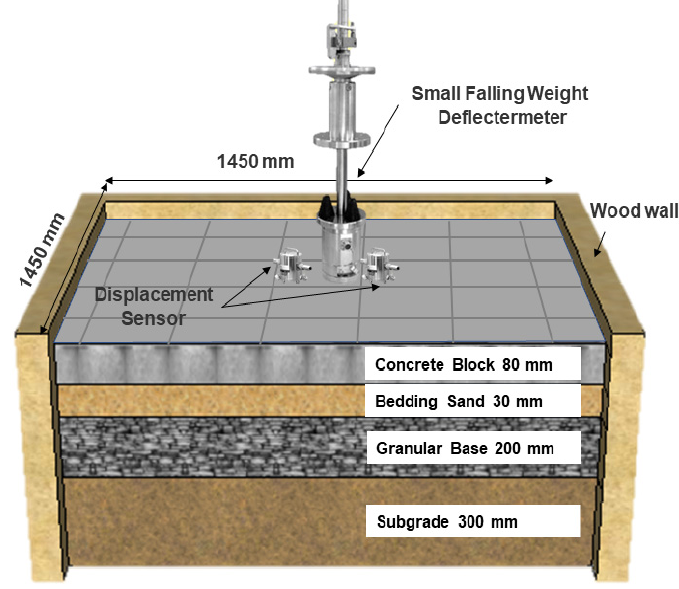
Figure 3. Pavement sections and experimental setup.